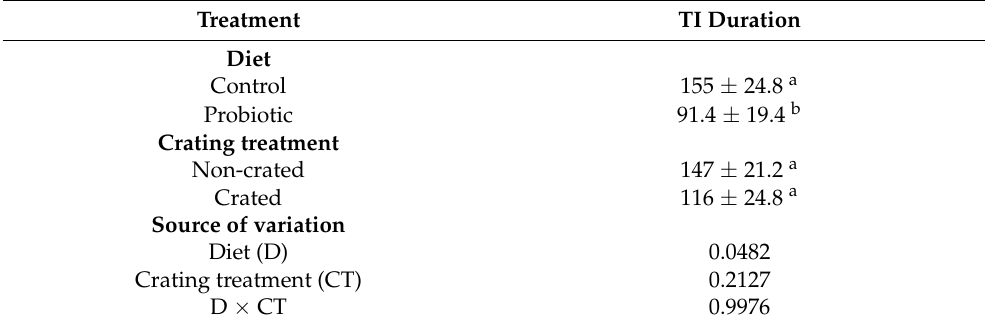
Table 5. Mean ( ± SEM) tonic immobility duration (s) by diet and crating treatment in ducks on day 21.